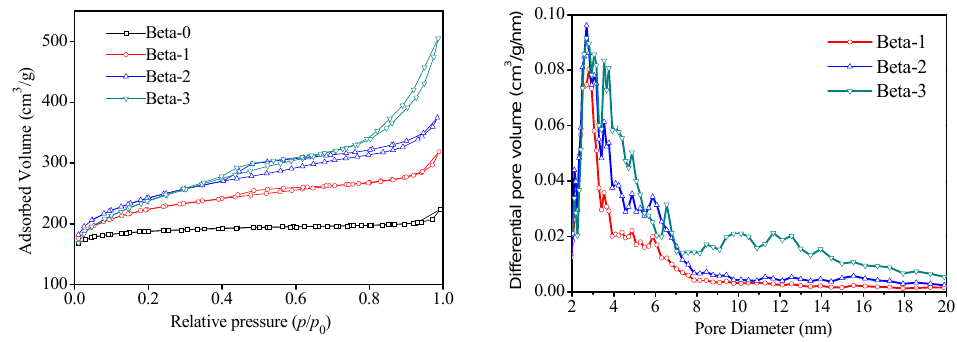
Figure 2. Nitrogen adsorption/desorption isotherms at 77 K and corresponding DFT pore size distributions of Beta zeolite samples.